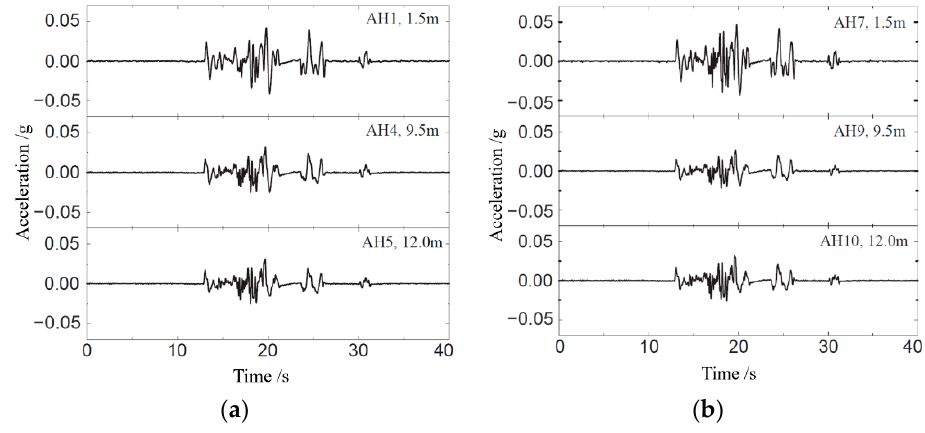
Figure 9. Acceleration time history: ( a ) in the structure; ( b ) in the model soil.